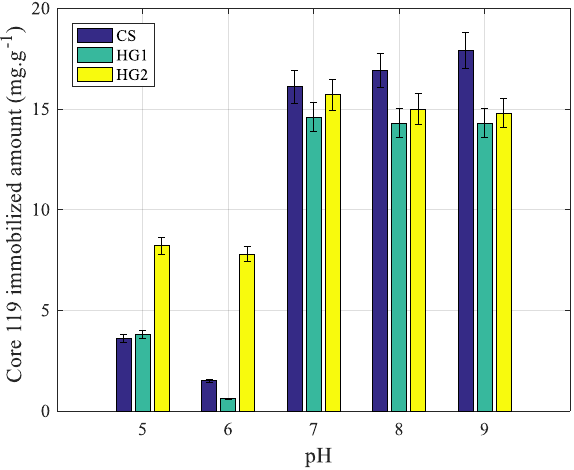
Figure 6. pH dependence of Core 119 fixation onto CS, HG1, and HG2 in presence of nickel. Conditions: phosphate bu ff ers at di ff erent pH (from 5 to 9), ionic strength 10 mM, adsorption temperature 20 ◦ C, [Ni] = 10 − 2 M.